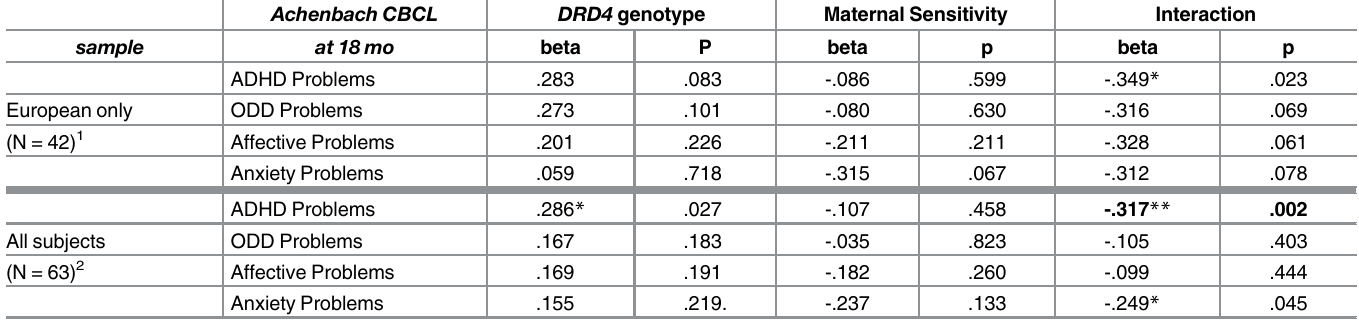
Table 3. Exploratory Analyses: Linear regression of effect of DRD4 genotype, maternal sensitivity, and their interaction on 18 month child DSM- problems subscales (Achenbach CBCL) §